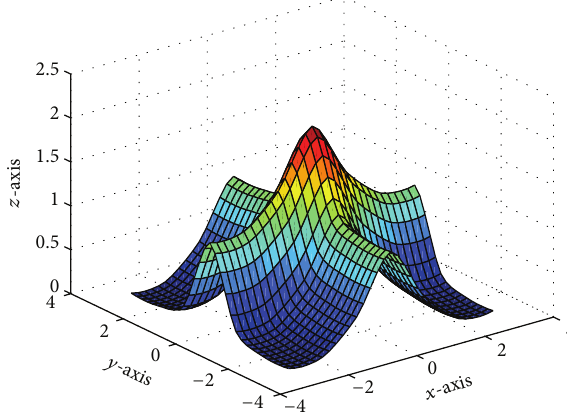
Figure 12: Positivity preserving by using our partially rational bicu- bic